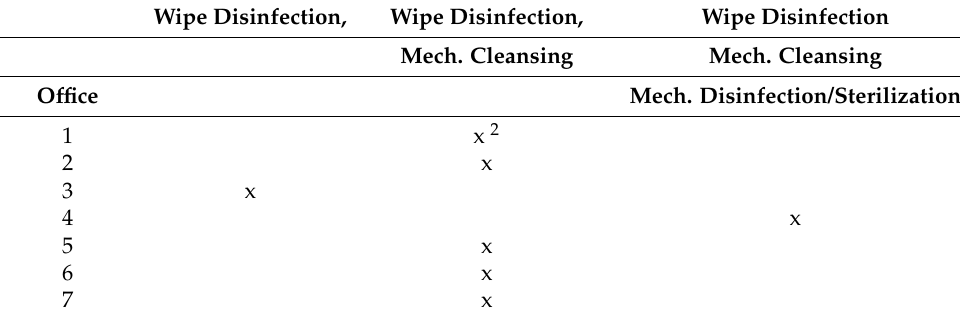
Table 4. Decontamination methods of the individual dental